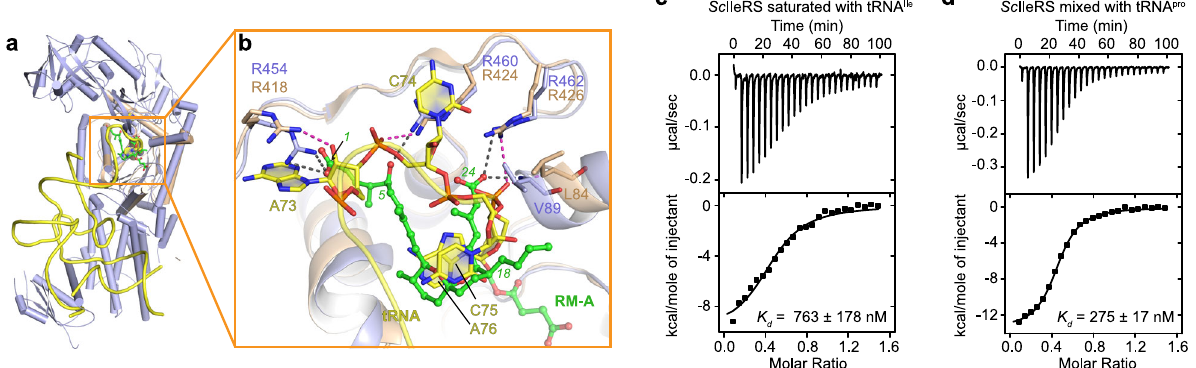
Fig. 5 RM-A represents the fi rst tRNA-site inhibitor of class I AARSs. a Structural superimposition of the catalytic domain of the E. coli LeuRS ∙ tRNA Leu complex (wheat, PDB ID: 4AQ7) with that of the Sc IleRS ∙ RM-A ∙ Ile-AMP complex (light blue) reveals that a large part of RM-A occupies the binding site of the tRNA 3 ’ CCA end. b Zoomed-in view of the con fl icts between RM-A and the 3 ’ CCA end of tRNA. The residues that form polar interactions (indicated as black dashed lines) with the C1-10 and C20-24 side chains of RM-A in Sc IleRS are shown in sticks, and the corresponding residues in E. coli LeuRS were found to form H-bonds (indicated as magenta dashed lines) with A74, C75 and A76 of tRNA Leu . c , d ITC titrations of RM-A to Sc IleRS premixed with in vitro transcribed tRNA Ile ( c ) and with tRNA Pro ( d